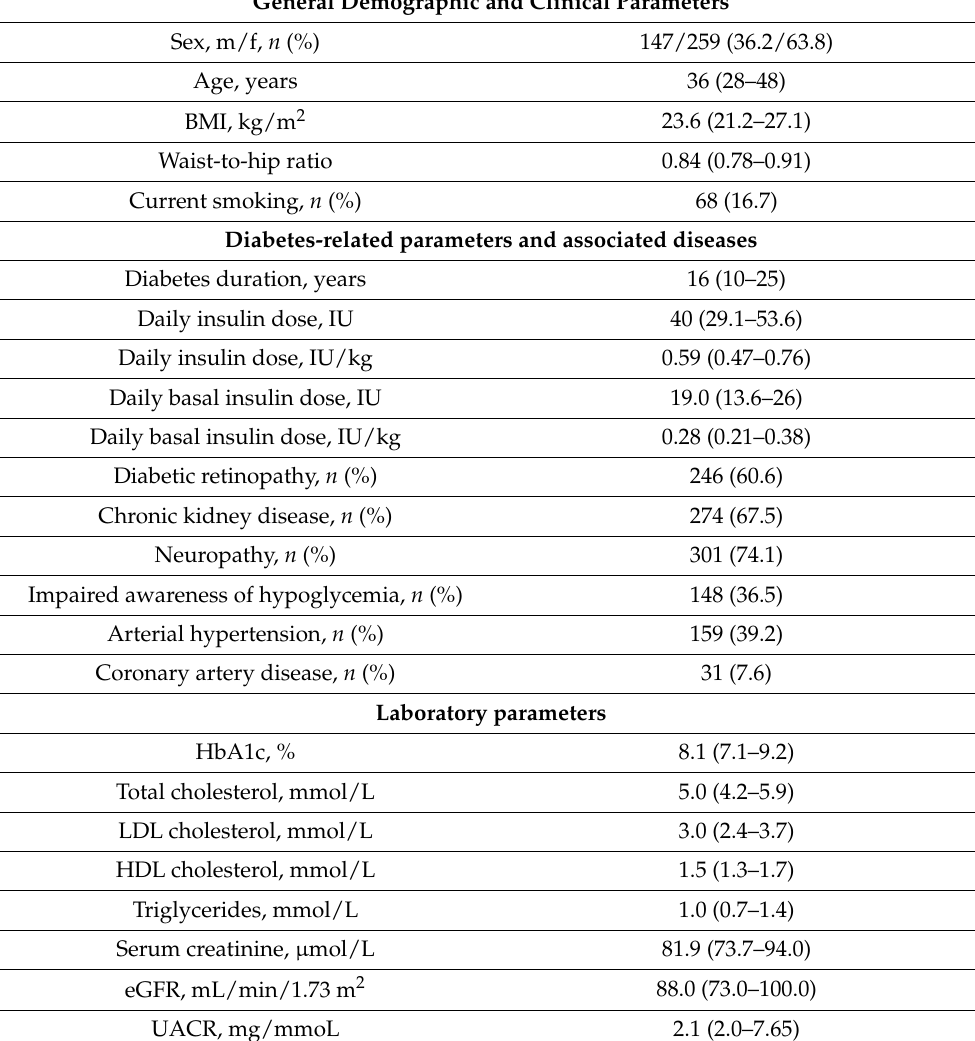
Table 2. Clinical characteristics of T1D